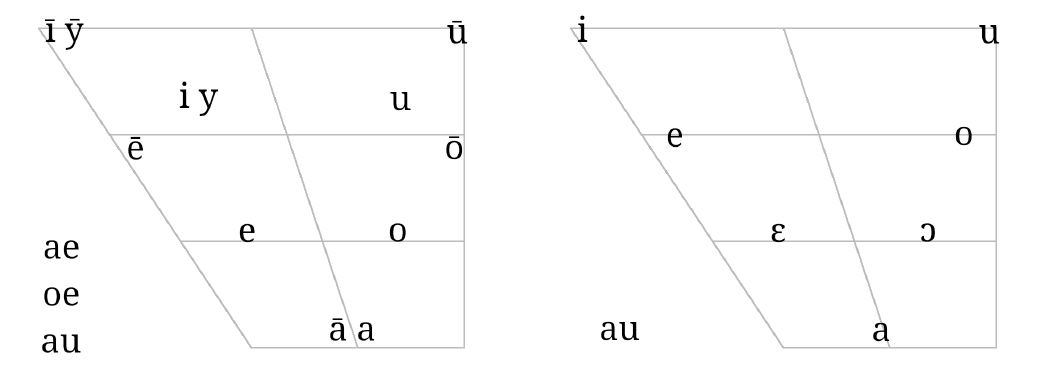
Figure 8. The vowel inventories of Classical Latin (left) and early Romance (right)